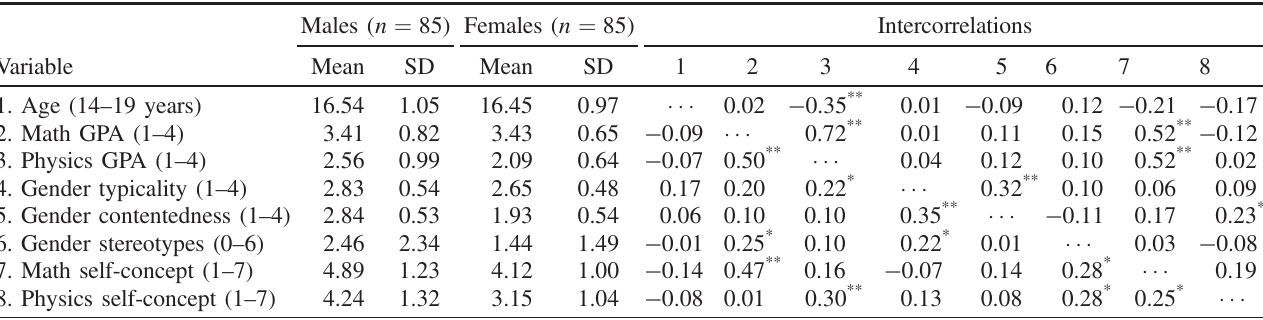
TABLE I. Means, standard deviations (SD), and correlations between study variables ( n ¼ 170